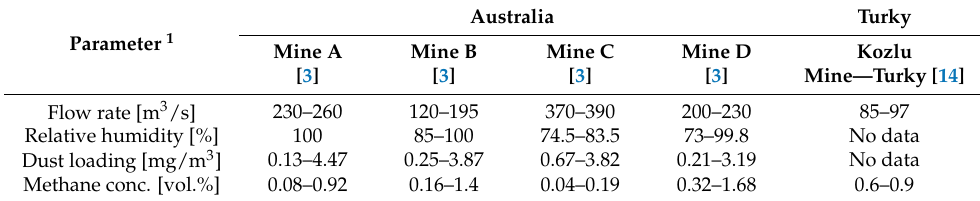
Table 1. The chosen data of VAM at different coal